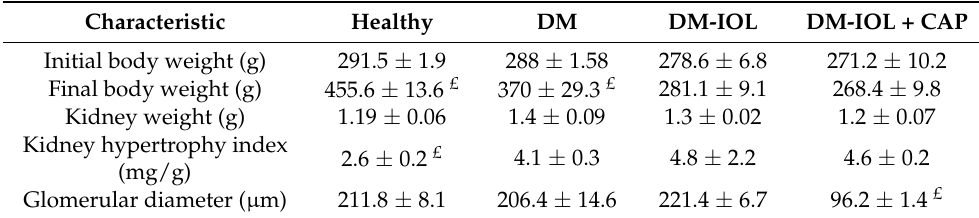
Table 1. Morphologic characteristics of diabetic rats (DM) with or without iron overload (IOL) and untreated or treated with capsaicin